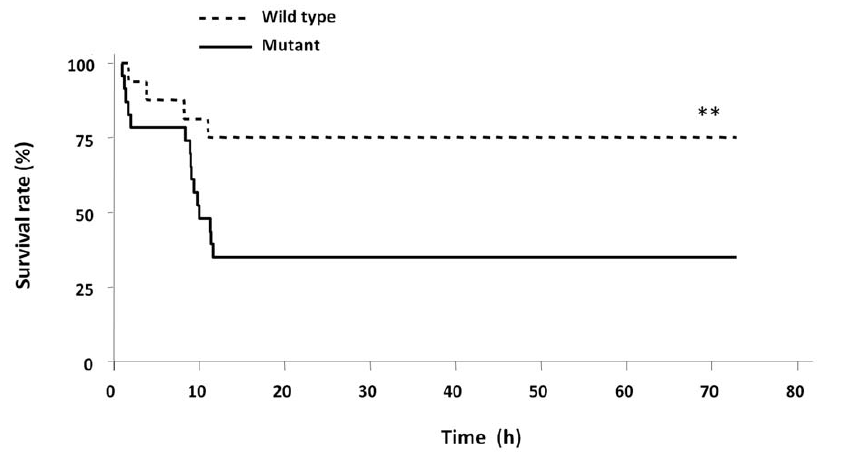
Figure 2. Comparison of heatstroke-induced lethality in mutant and wild type mice. Survival rates (%) of wild type and mutant mice after heatstroke are shown over 72 hours from the onset of heatstroke. Heatstroke was induced by passive exposure to environmental heat until the core temperature reached 42.7 u C. **P , 0.001 between the two groups analyzed by the Kaplan-Meier log-rank test.